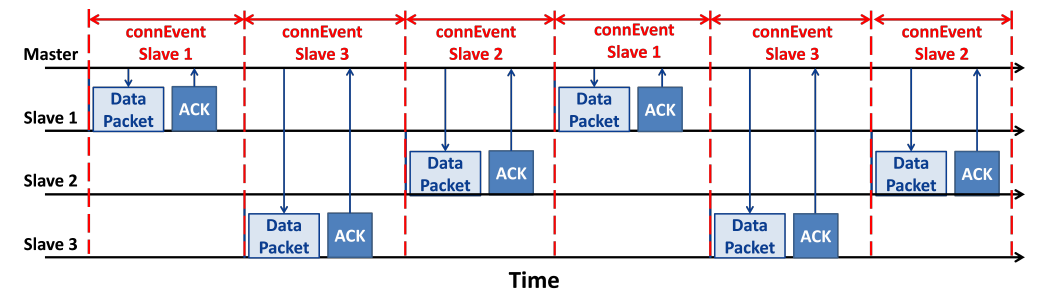
Figure 14. Multi slave communication in a network with a star topology (see Section 2.4). There is a master sending data with three slaves . This is the particular case of non-overlapping, i.e., when different slaves do not share the same interval of time for the communication with the master . In fact, as can be seen, all the connEvents are distributed without overlapping. The black arrows indicate how the time goes. The blue arrows outline the direction of the